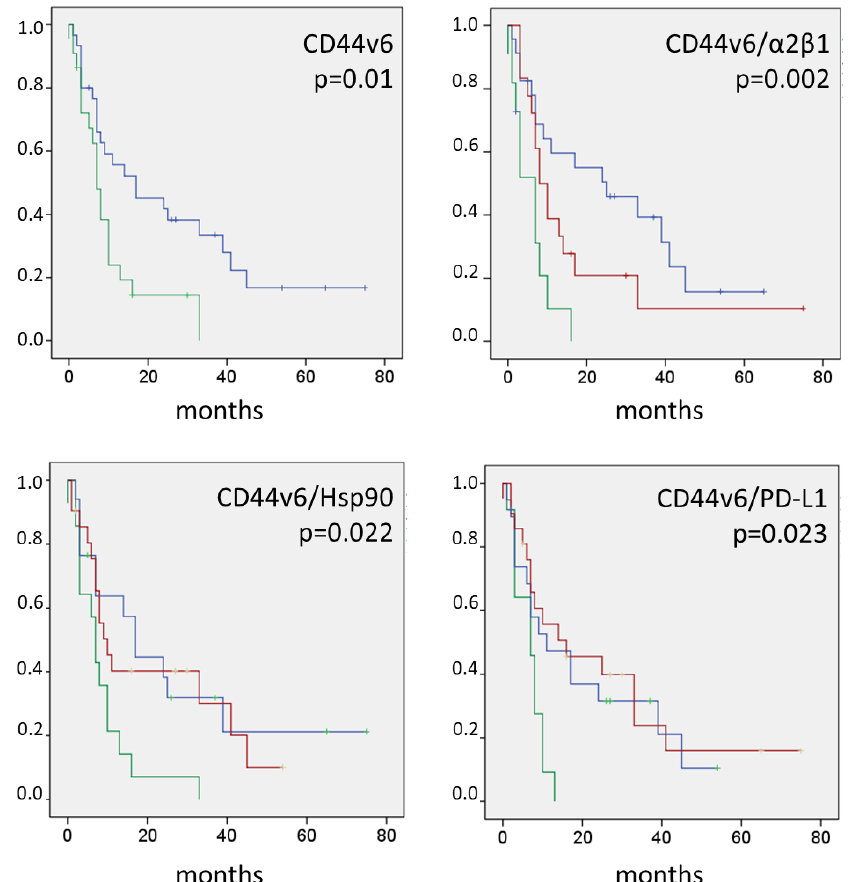
Figure 3. Kaplan–Meier Curves of CD44v6-Related Biomarker Expression in Colorectal Liver Metastases. Blue lines , low/low expression; green lines , high/high expression; red lines , high/low and low/high expression; log-rank p -values are given; cut-off values defining high- and low-level expression for the individual biomarker are given in Table 3. Table 6. Multivariate Survival Analysis of CD44v6-Related Dual Biomarker Expression in Colorec- tal Liver Metastases .